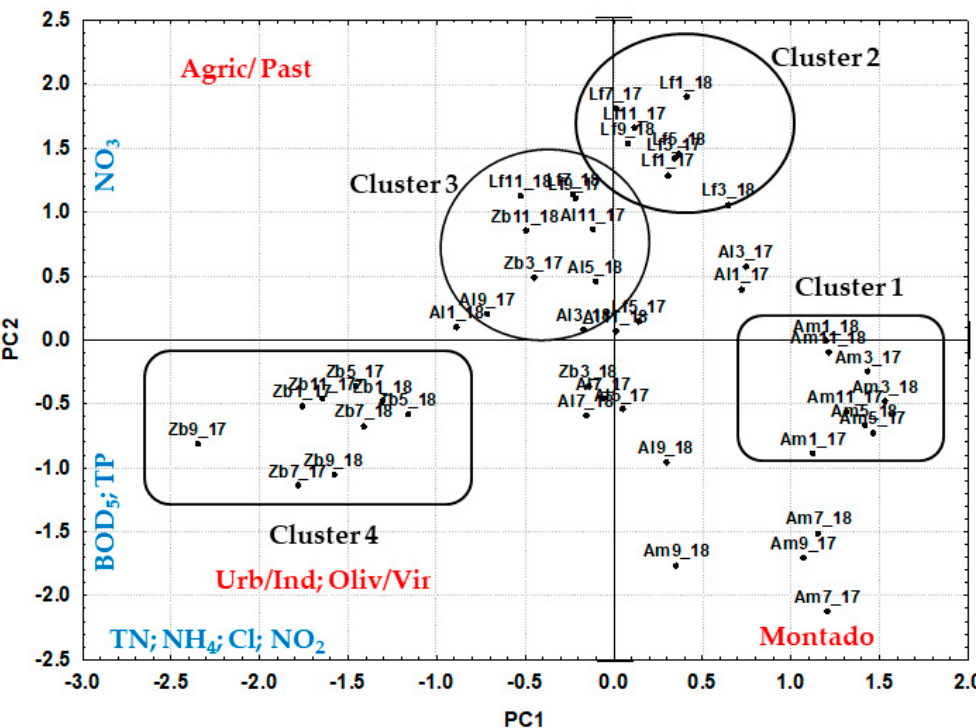
Figure 5. Scores of the water samples of streams, on the bidimensional plan defined by the first two principle components (PC) and parameters that most influence the explanation of each PC. In the figure are displayed the statistically significant clusters obtained with the Euclidean distance of (Dlink / Dmax) × 100 <